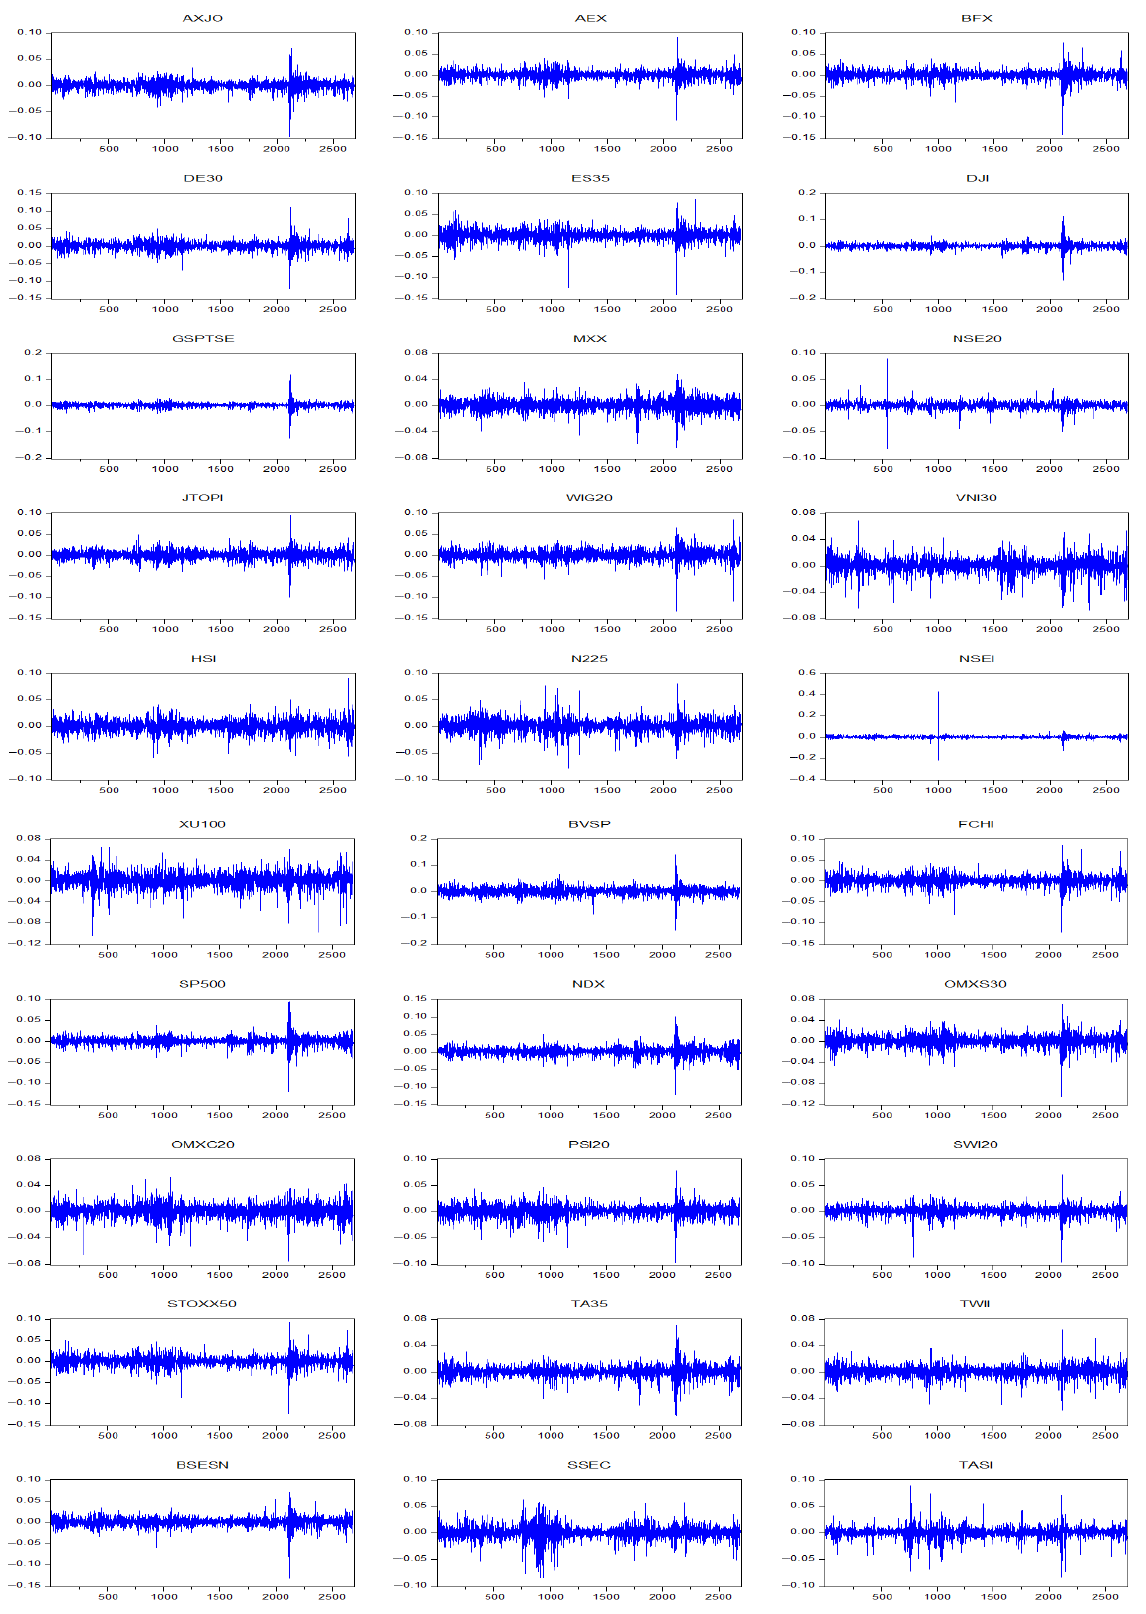
Figure 2. Daily Lognormal Returns of 30 Stock Indices, 1 January 2012–1 June 2022